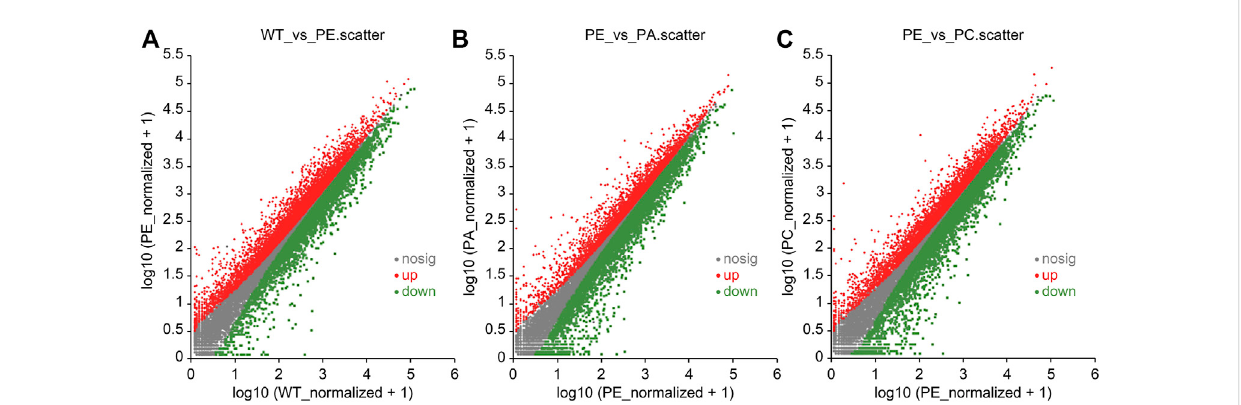
the point is from the diagonal, the greater the difference in gene expression between the two compared groups.